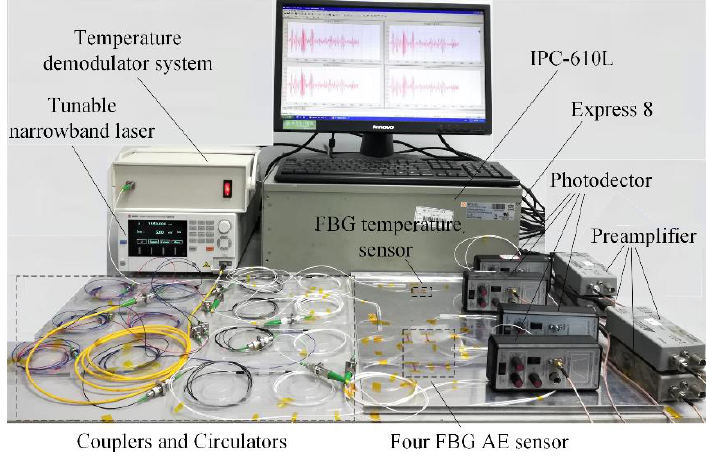
Figure 6. FBG AE system setup.